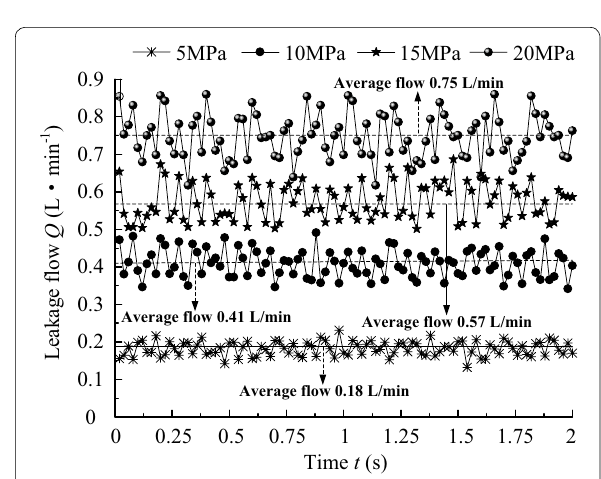
Figure 13 Leakage flow of port plate pairs at various inlet pressure